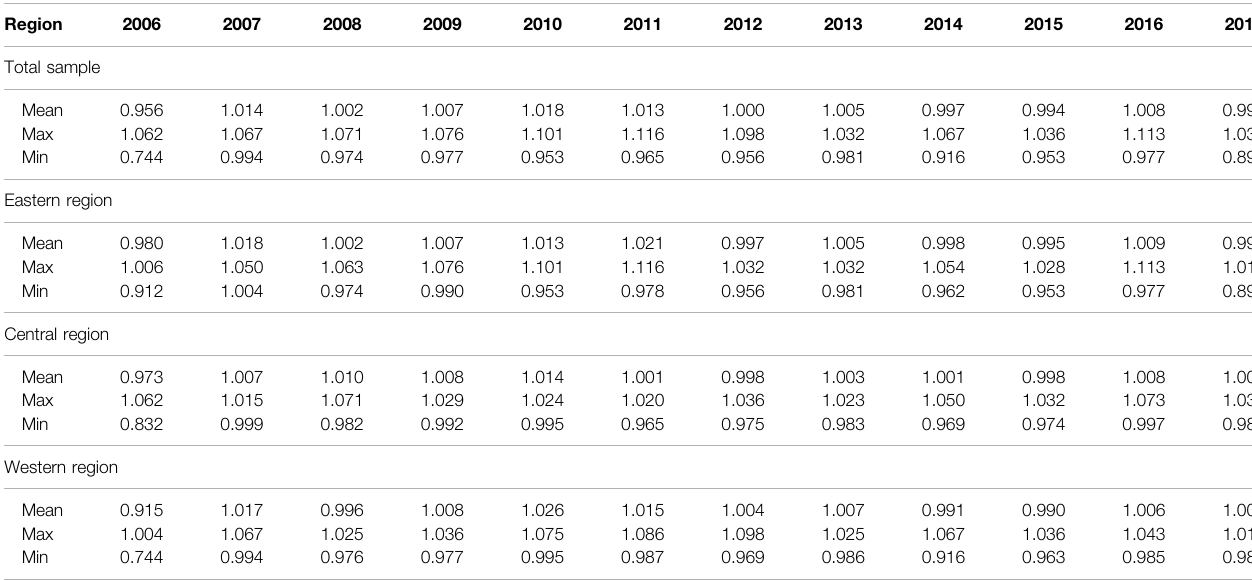
TABLE 3 | Calculation results of MMUEI